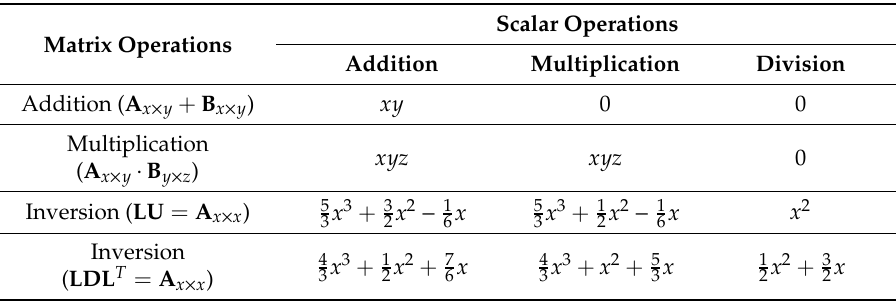
Table 3. Scalar operation number polynomials of matrix